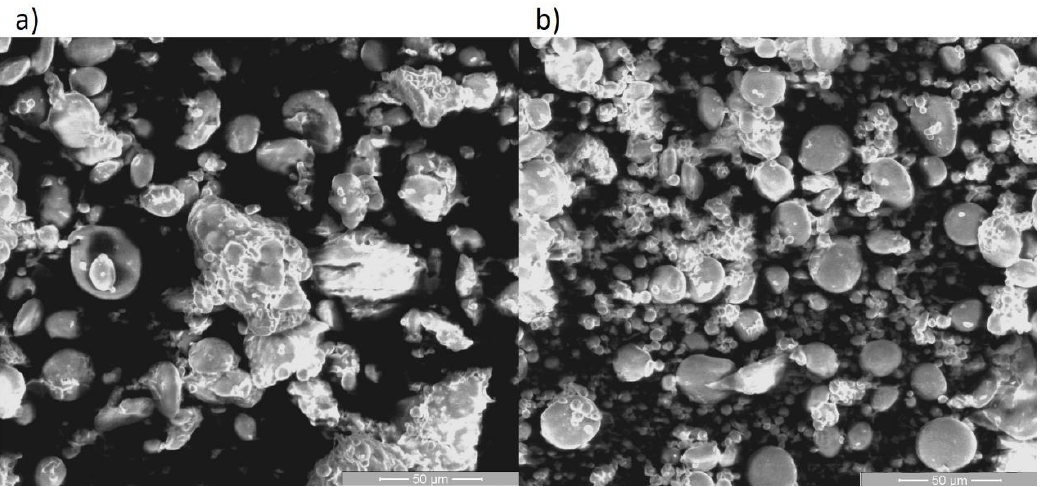
Figure 5. SEM micrographs of graham flour: ( a ) untreated and ( b ) scCO 2 -treated at 300 bar and 3 h at 1000× magnification. Table 1. Comparison of the particle size distribution of the graham flour and the moisture content as a function of scCO 2